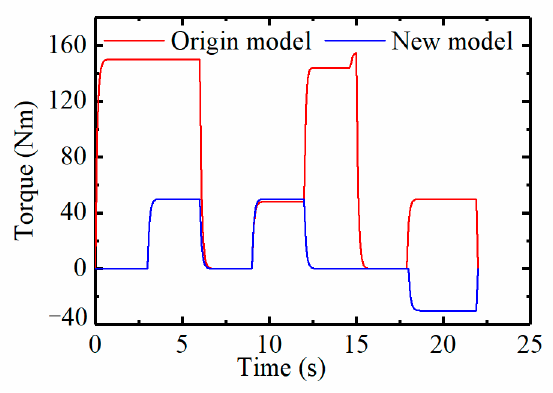
Figure 8. The motor torque comparison chart.